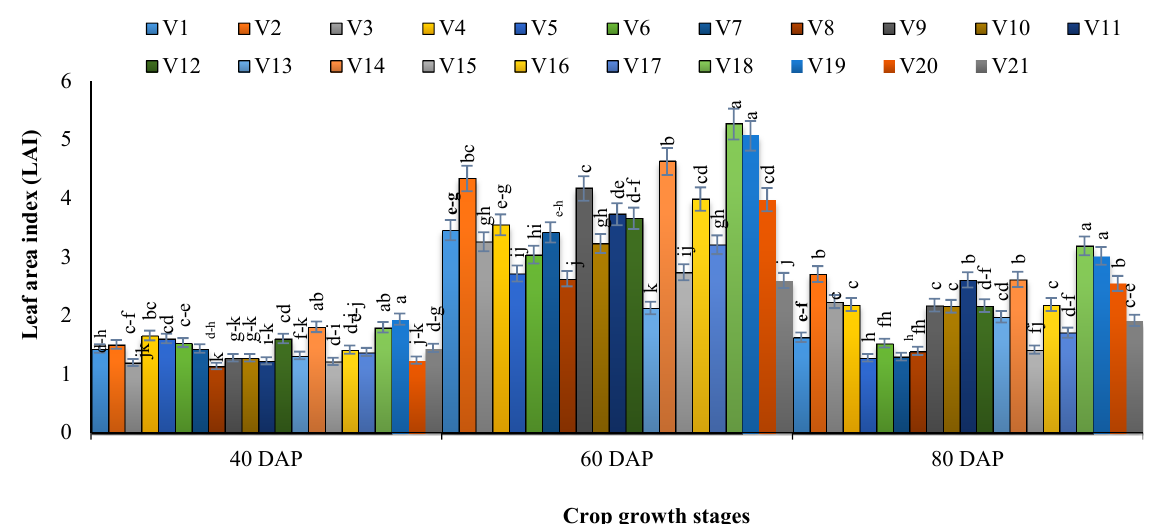
Figure 3. Leaf area index of different potato cultivars during various stages of growth (two years pooled data); values with different lower case letters are significantly different between each other at the 5% level of significance ( p ≤ 0.05); vertical bars represent standard error of mean values.